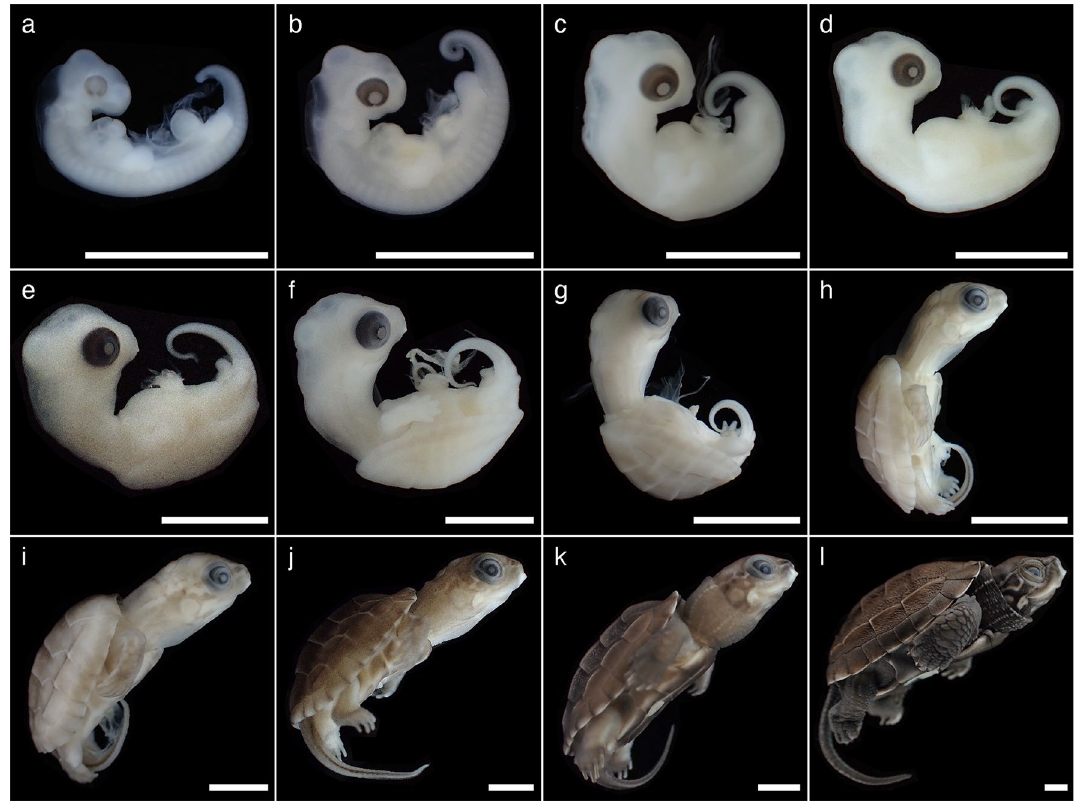
Figure 2. Stages 13–24 of Mauremys reevesii in lateral view. ( a ) Stage 13. ( b ) Stage 14. ( c ) Stage 15. ( d ) Stage 16. ( e ) Stage 17. ( f ) Stage 18. ( g ) Stage 19. ( h ) Stage 20. ( i ) Stage 21. ( j ) Stage 22. ( k ) Stage 23. ( l ) Stage 24. The scale bar is 5 between the changes in egg weight and the embryonic stage was weak with r to be 0.32 ( P -value = 6.8 × 10 –4 ). No sexual dimorphic features were observed with respect of the external morphology during the embryonic development at either FPT (31 °C) or MPT (26 °C). The representative individual of each stage is shown in Fig. 2 in lateral view, and Supplementary Figures S1 and S2 in dorsal and ventral view, respectively; mandible formations are shown in Fig. 3. The representative digit formations of selected stages are shown in Fig. 4, while